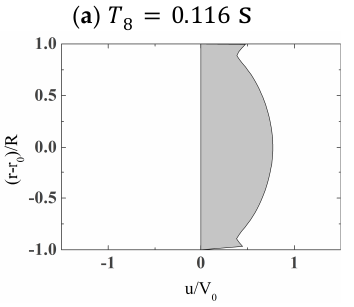
1 monitoring position at this time is 126,411 Pa, and the